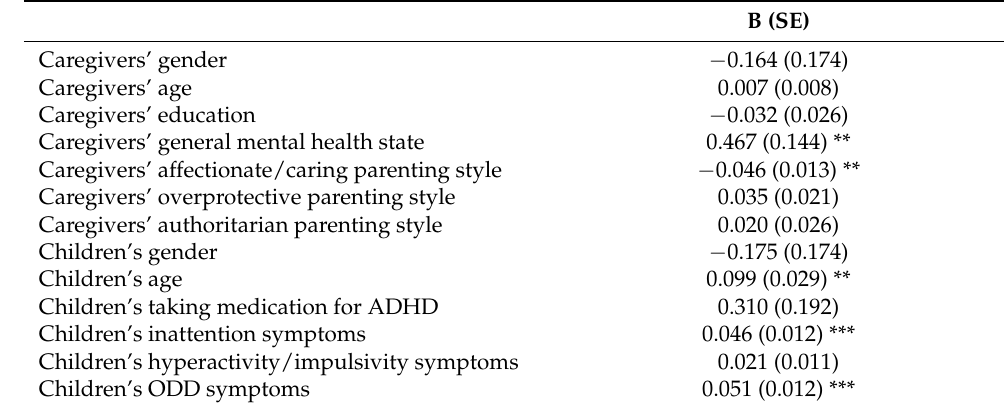
Table 3. Associations of Children’s Age, Inattention and ODD Symptoms with Caregivers’ Difficulty to Manage Child’s Smartphone Use: Backward Stepwise Multivariate Linear Regression Analysis. Caregivers’ years of